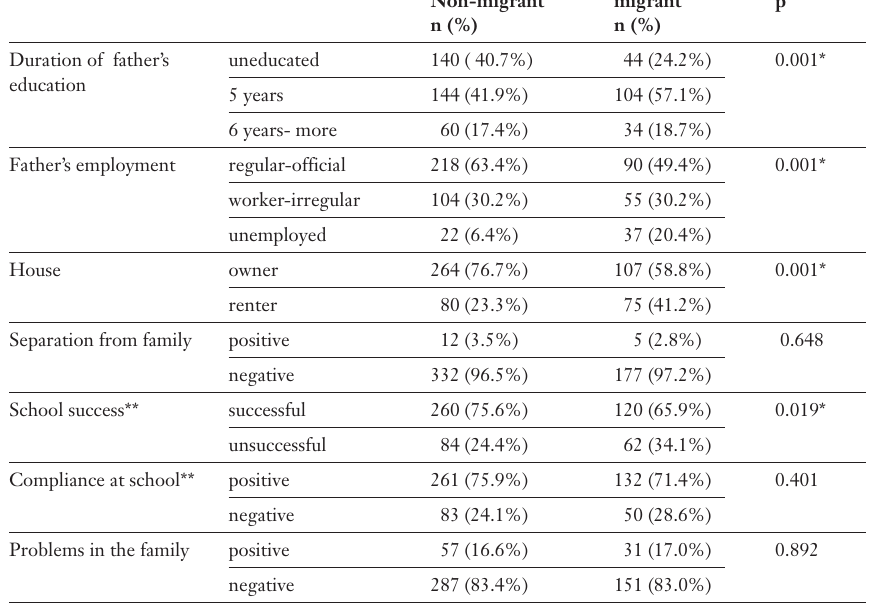
(33.53 ± 6.53 vs. 33.44 ± 6.44), self-esteem scores on CSEI (36.82 ± 6.65 vs. 37.38 ± 7.18) and teach- ers’ scores on RTRS (8.87 ± 6.81 vs. 7.65 ± 4.55) (table 2). Migrant children had significantly lower self-esteem (35.89 ± 6.18 vs. 37.97 ± 7.25 on CSEI; p = 0.001), higher depressive (13.50 ± 6.55 vs. 11.99